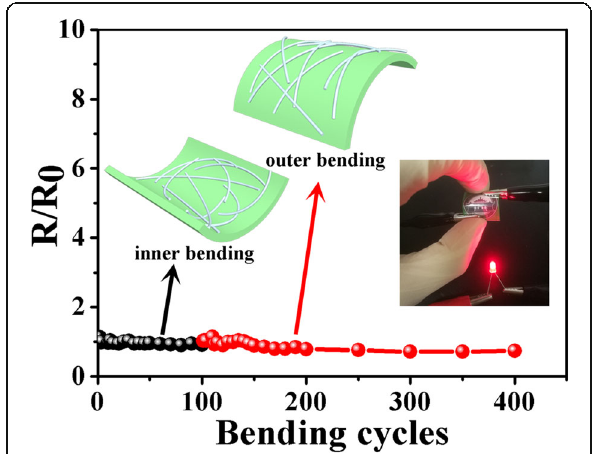
Fig. 8 The bending test, including inner bending and outer bending. Both the bending radios are 1.5 cm. The inset shows the bent Ag NTEs is still conductive over the whole surface. ( R and R 0 represent the sheet resistance of films before and after bending test,